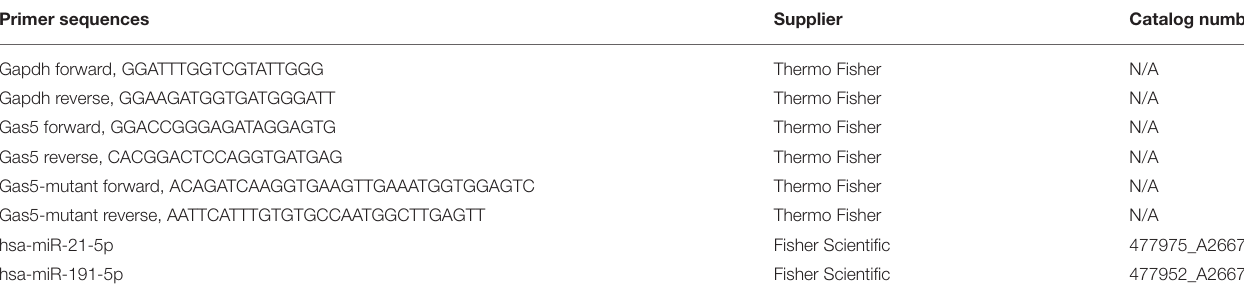
TABLE 2 | Primer sequences used for RT-qPCR experiments in the